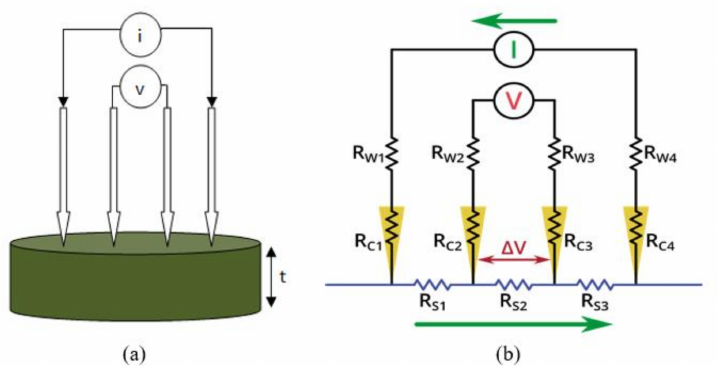
Figure 14. ( a ) Four-probe contact for conductivity measurement of PANI (ES) pallet. ( b ) Equivalent circuit diagram of a four-point probe, showing the wire resistances as R W , contact resistances as R C , and sample resistances as R S . The green arrows represent current